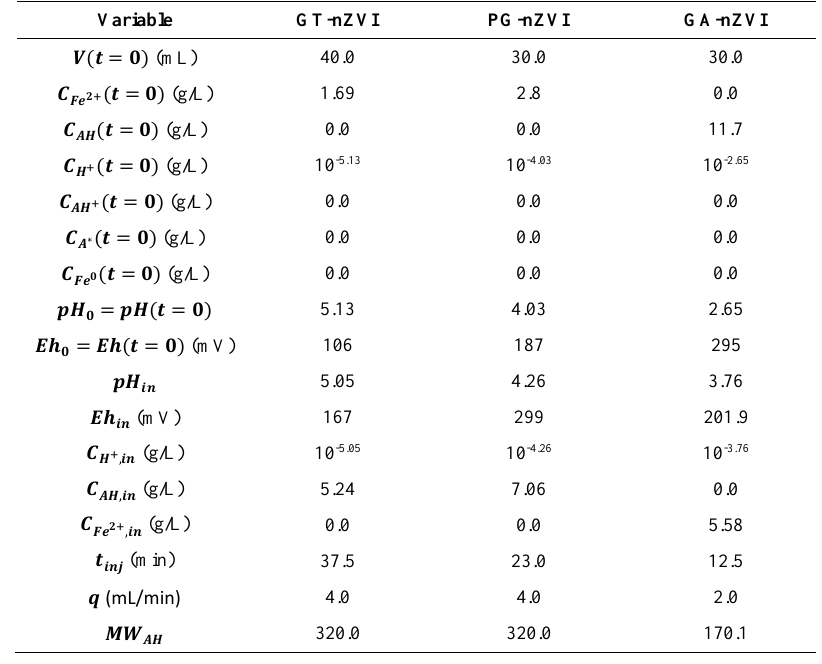
Table 3. Initial conditions and parameter values used in simulations.